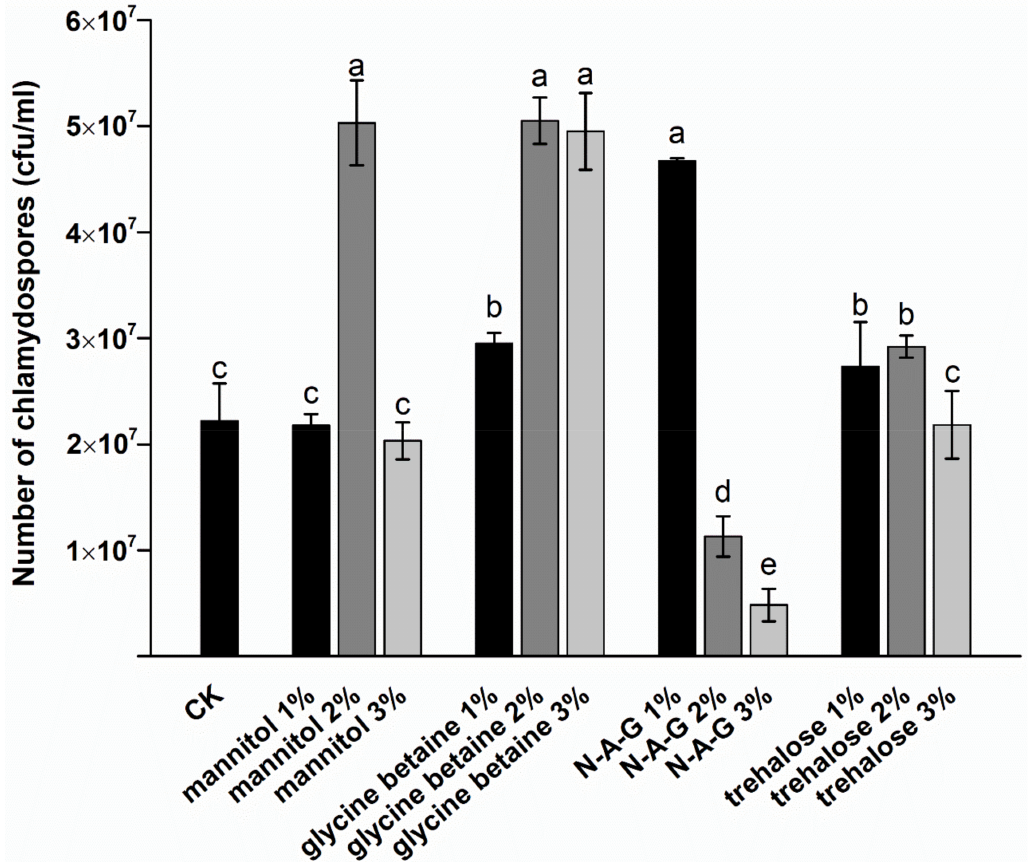
Figure 1. Effects of different exogenous regulators on the chlamydospore yield. N-A-G: N- acetylglucosamine. The data are from three independent repeated experiments. The different letters above the bars indicate a significant difference in the chlamydospore yield for each treatment, according to the least significant difference test ( p <